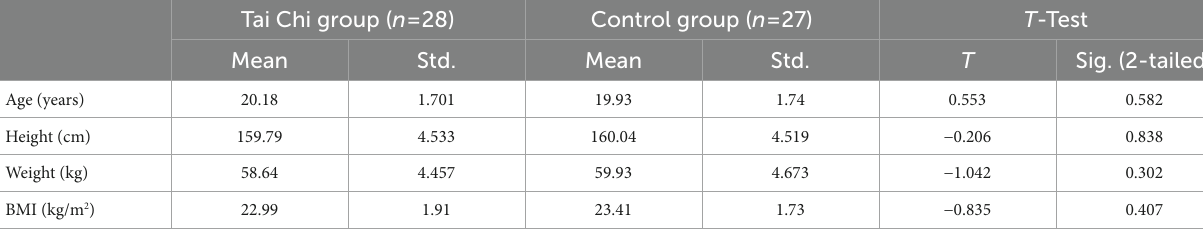
TABLE 1 Age, height, weight, and BMI of the participants in Tai Chi group and control group.